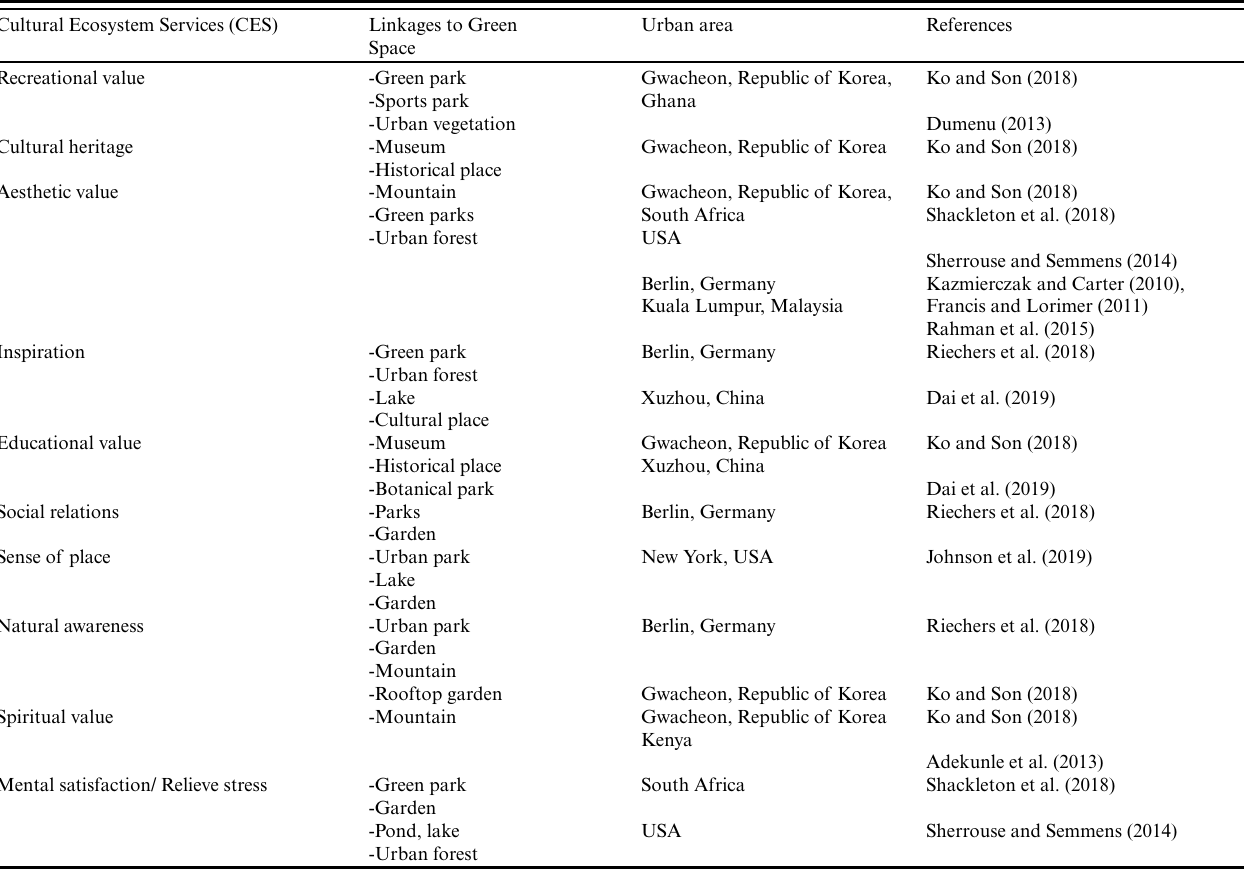
Table 1 . Cultural Ecosystem Services at country scale and its linkage to urban green spaces. Cultural Ecosystem Services